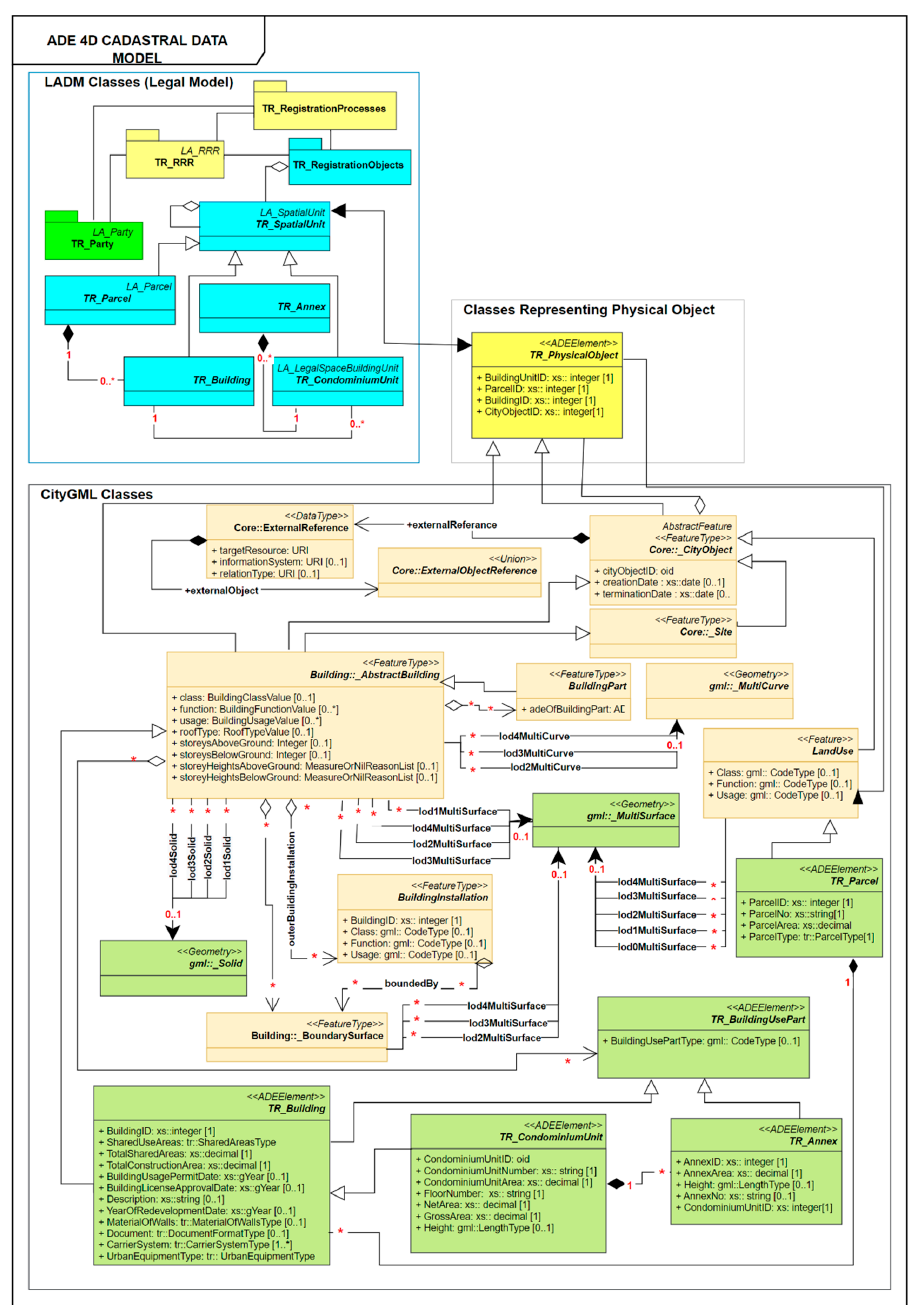
Figure 4. Shows the conceptual model for the new ADE 4D Cadastral Data Model . 3.4. Integrated Models Developed Using International Standards for Cadastral Purposes Integrated information models are designed for the combination of legal and physi- cal objects, demonstrating that defining semantic information is possible at a representa- tion level. Generally, there are two methods for creating integrated information models. The former is enriching physical information models with legal information. The latter